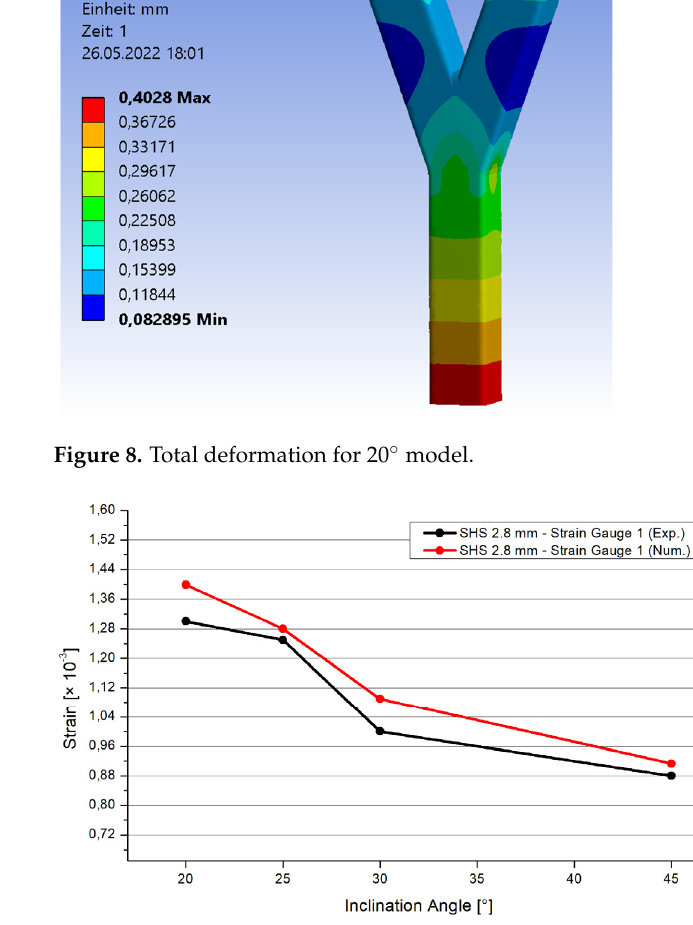
Figure 9. Comparison between the numerical and experimental results. Position 1.